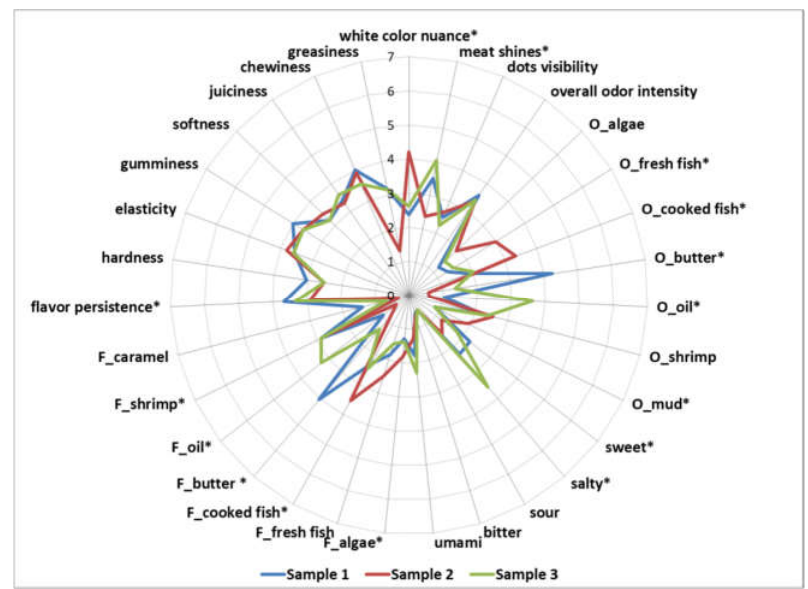
Figure 2. Spider plot of sensory profiles of crayfish meat samples prepared in three different cooking procedures (Sample 1—crayfish meat prepared with sautéing on butter, Sample 2—crayfish meat prepared with poaching; Sample 3—crayfish meat prepared with shallow-fat frying; * next to the descriptor name indicates statistical difference of means determined by Tukey HSD test at p < 0.05) (O_ in the name of descriptor indicates odor attribute, whereas F_ in the name of descriptor indicates flavor attribute).